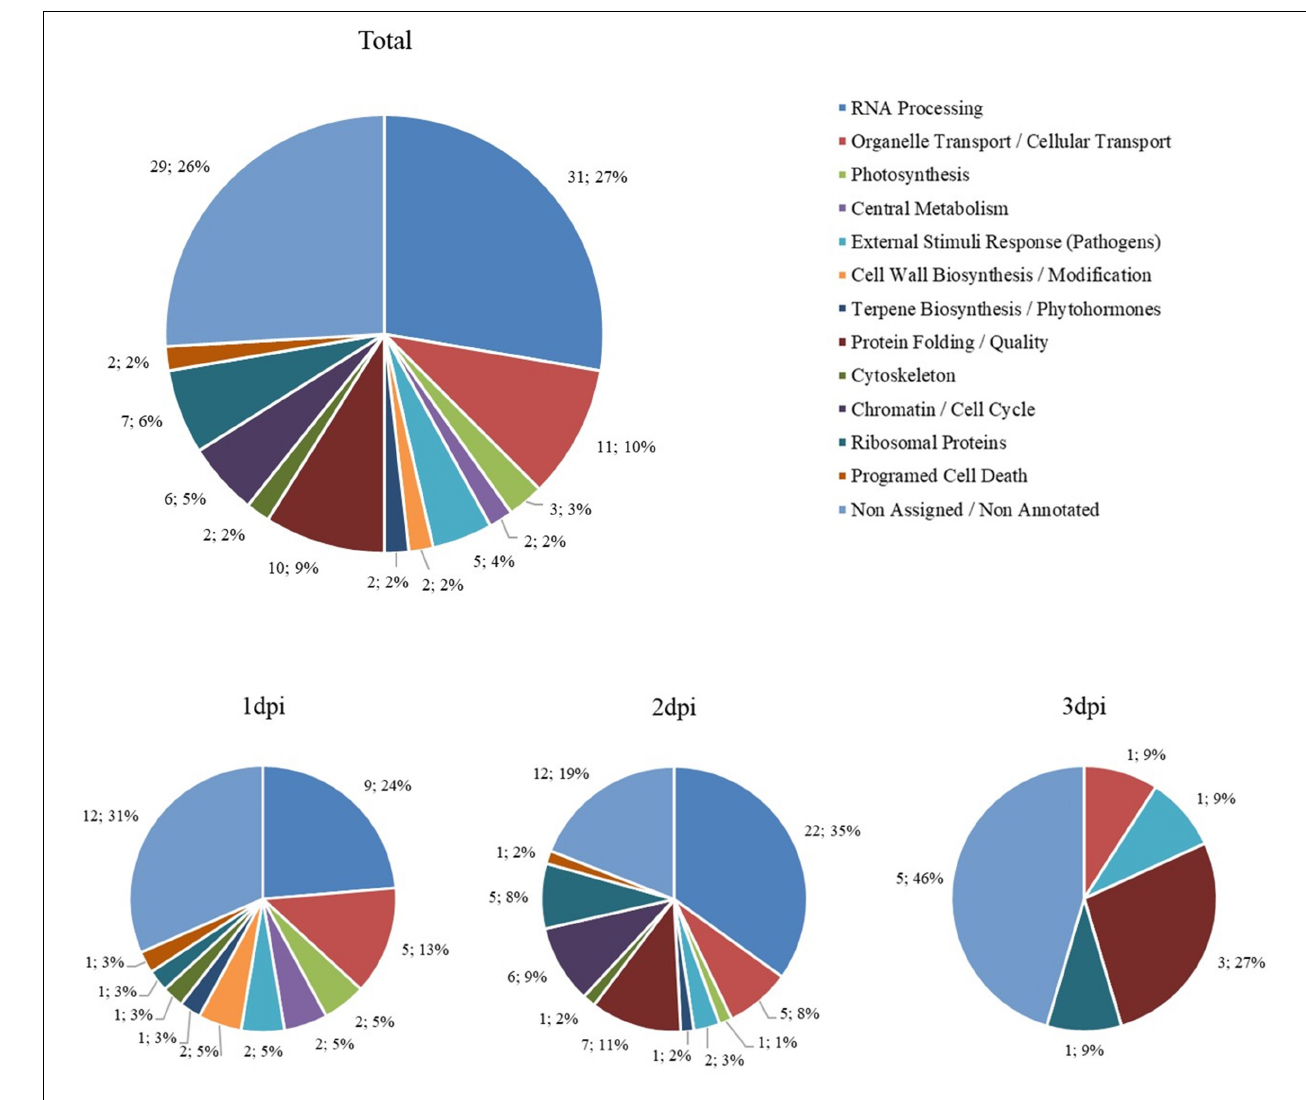
FIGURE 10 | Biological groups of more abundant proteins. The number of differentially more abundant proteins when comparing His.LotP with the control, represented by their biological group. Data are represented as the total amount and percentage of proteins more abundant over 3 days, as well as 1, 2, and 3